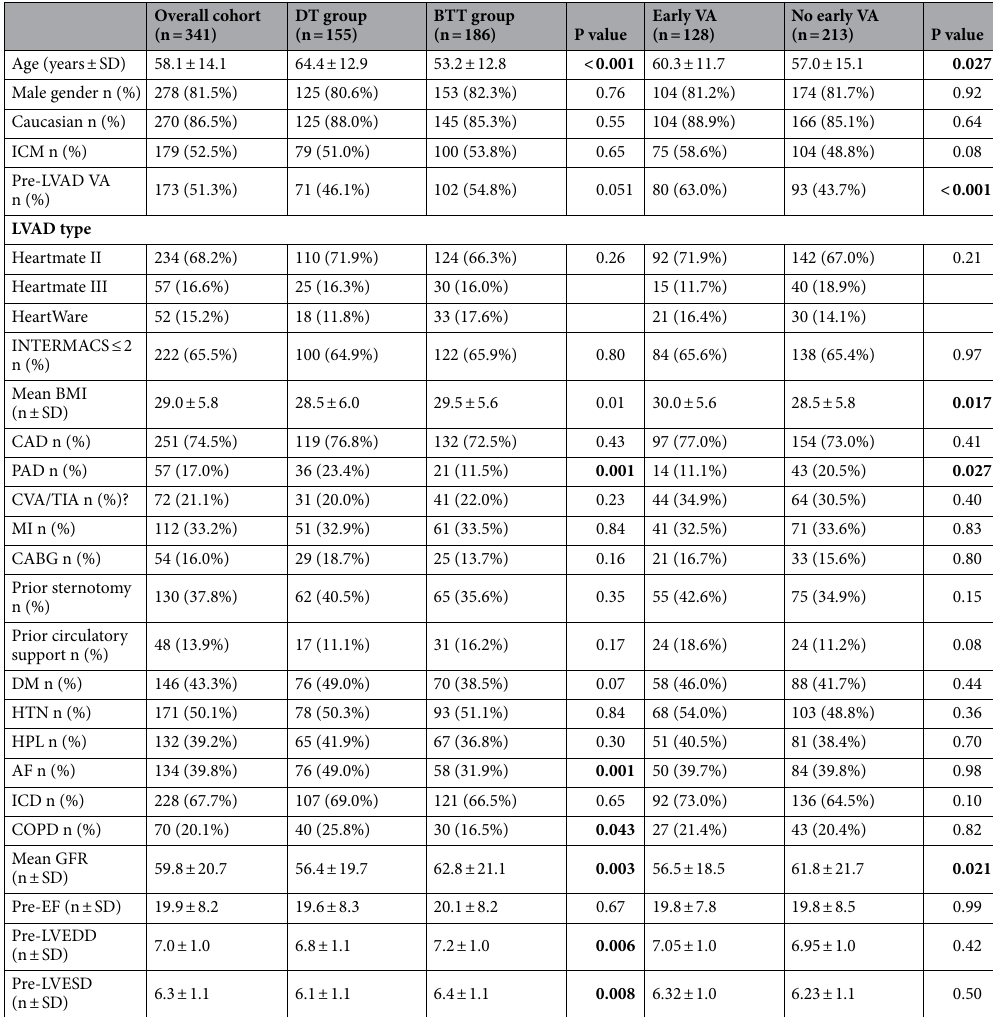
Table 1. Baseline characteristics of LVAD cohort. AF atrial fibrillation, BMI body mass index, BTT bridge to transplant, CABG coronary artery bypass graft, CAD coronary artery disease, COPD chronic obstructive pulmonary disease, CVA cerebrovascular accident, DM diabetes mellitus, DT destination therapy, GFR glomerular filtration rate, HPL hyperlipidemia, HTN hypertension, ICD Implantable cardioverter-defibrillator, ICM ischemic cardiomyopathy, INTERMACS Interagency Registry for Mechanically Assisted Circulatory Support, LVAD left ventricular assist device, LVEDD left ventricular end-diastolic diameter, LVESD left ventricular end-systolic diameter, MI myocardial infarction, PAD peripheral artery disease, TIA transient ischemic attack, VA ventricular arrhythmia. P values presented in bold are statistically significant